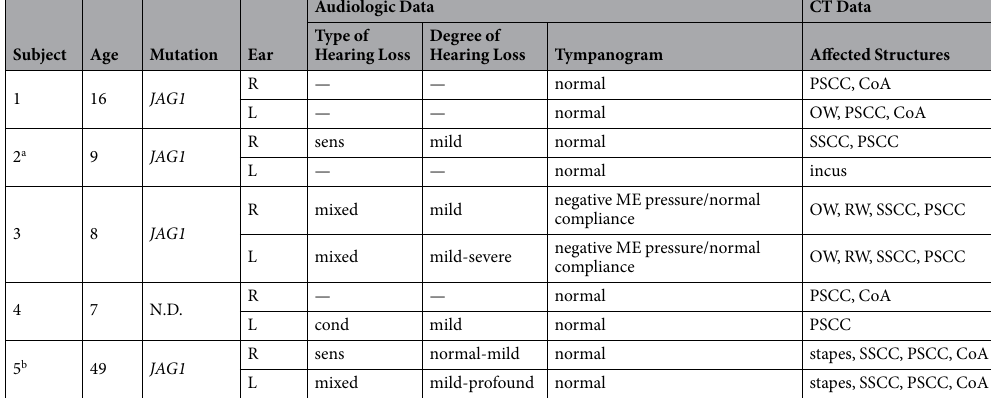
a JAG1 missense mutation but only a subset of AGS features 14 , and the presence of JAG1 mutations presenting